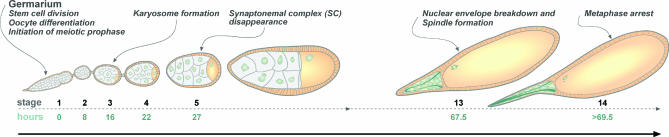
Oocyte Development in D. melanogaster
This figure displays a schematic depiction of oocyte development showing the timing (in hours) of the relevant stages. The end of meiotic prophase, as defined by SC dissolution, occurs at stages 5–6. By the end of stages 5–6, the chromosomes have condensed into a dense mass known as the karyosome, as pointed out by Mahowald and Kambysellis [2]. The karyosome remains compacted until stages 8–10, at which time it decondenses and a high level of transcription is observed. The chromosomes recompact during stages 11 and 12 to form a tight mass that is released into the cytoplasm upon NEB at stage 13. The end of pachytene is separated from NEB by approximately 40 h.